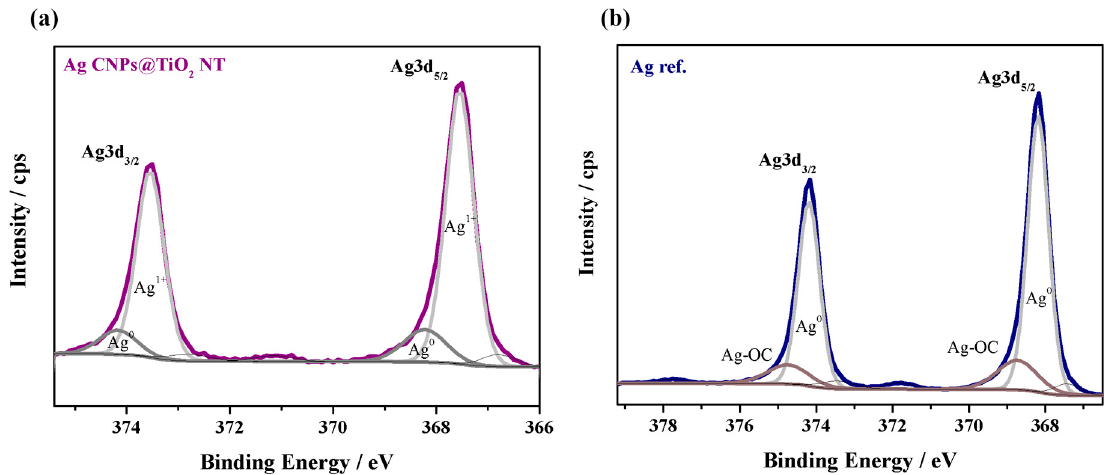
Figure 10. The Ag3d XPS spectra after the deconvolution procedure for AgCNPs deposited on titanium oxide nanotubes (TiO 2 NT) (AgCNPs@TiO 2 NT) ( a ) and electrochemically activated silver (Ag reference) ( b ).